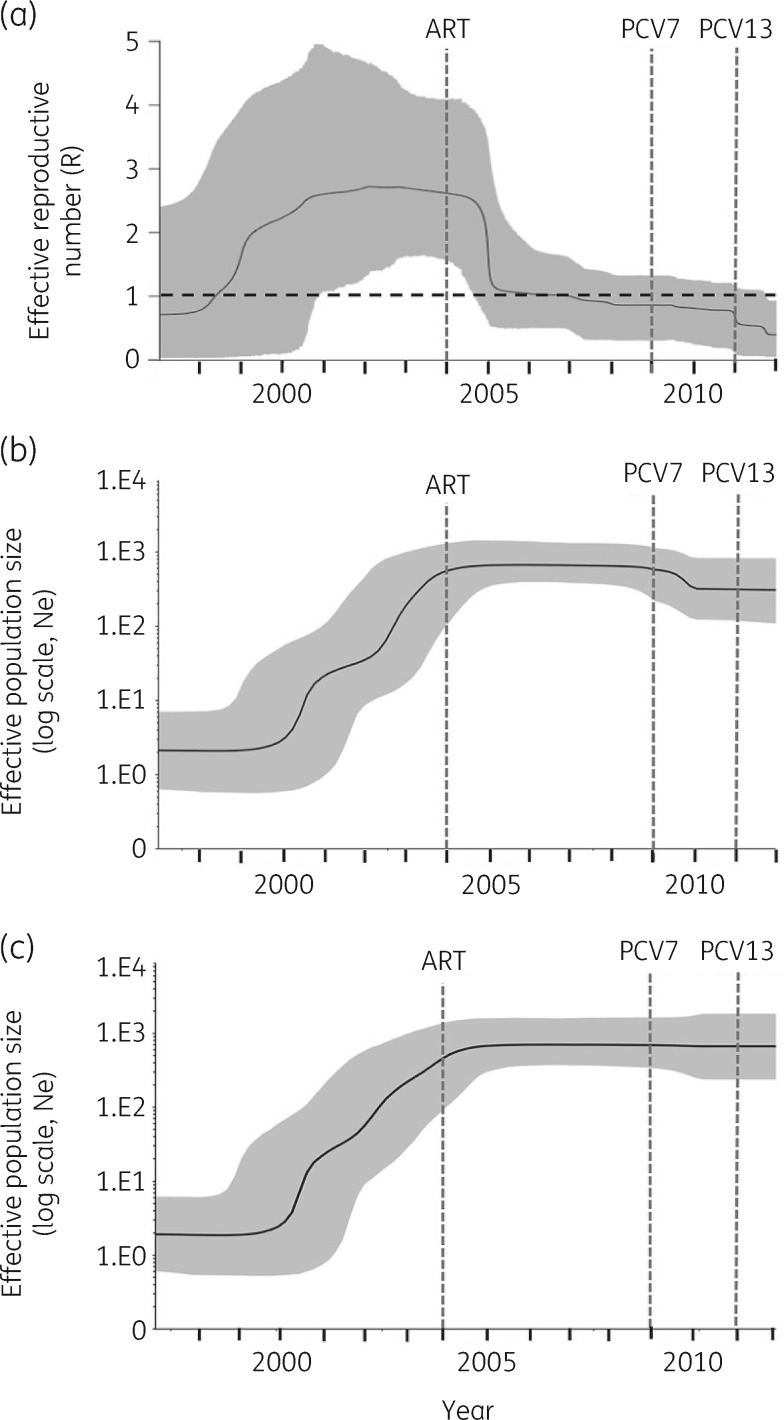
(a) Birth–death skyline plot of inferred changes in R of S. pneumoniae tet(S/M) CC230 sublineage using IPD isolates (n=105). (b) Coalescent-based skyline plot of inferred changes in the effective population size (Ne) of the S. pneumoniae tet(S/M) CC230 sublineage using both IPD and carriage isolates (n=129) and (c) using only IPD isolates (n=105). The black continuous line shows the median of R in (a) and Ne in (b) and (c). The background area represents the 95% HPD intervals. R>1 indicates a growing epidemic, whereas R<1 indicates a declining epidemic.